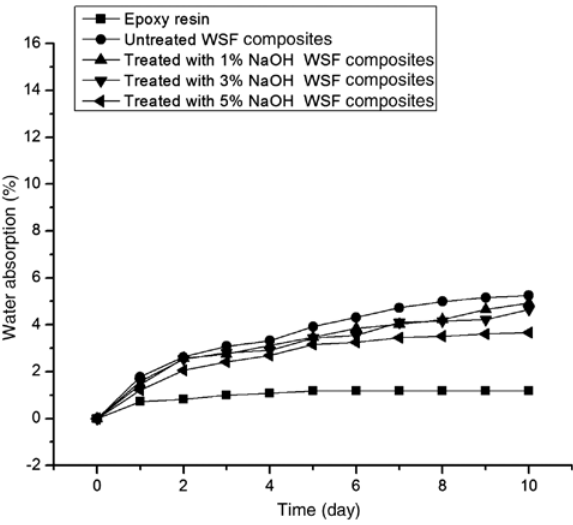
Figure 8: Water absorption curve for the WSF